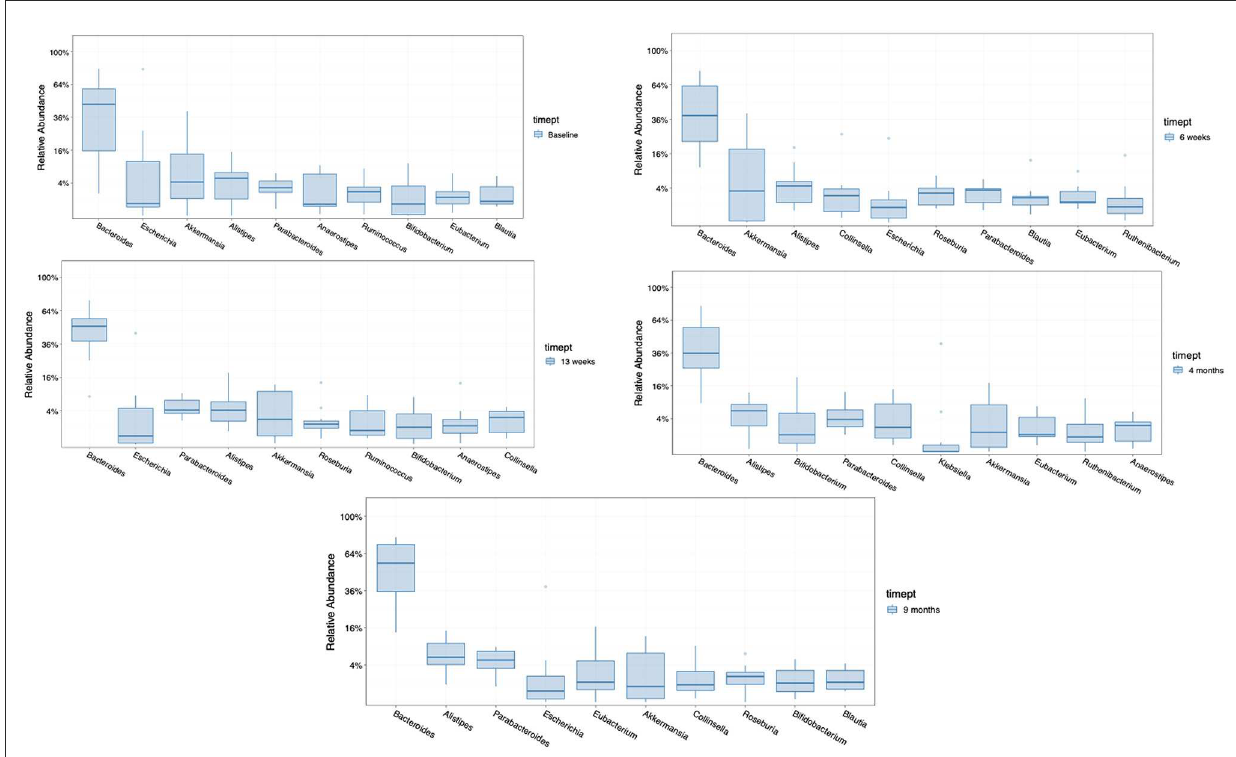
FIGURE4 Comparison of the 10 most abundant genera in the group receiving FMT, at baseline, at 6 weeks (med-therapy), at 13 weeks (1 week after completing therapy), and at 4 and 9 months (1–6 months after completing therapy).